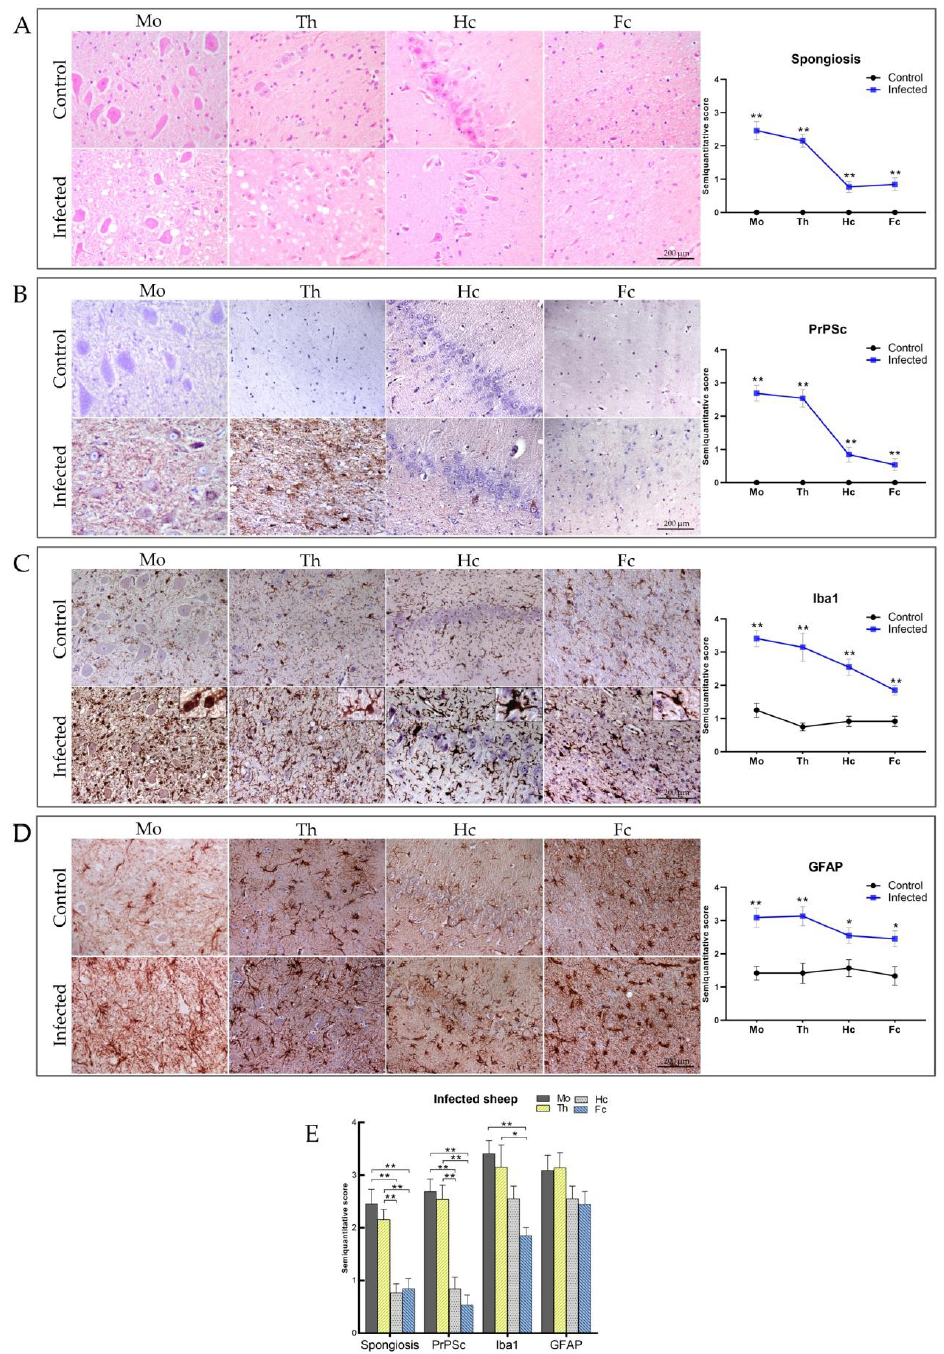
Figure 1. Representative neuropathology and immunohistochemical assessment of spongiosis, PrP Sc deposition, microgliosis, and astrogliosis in the CNS of control and scrapie-infected sheep in the medulla oblongata (Mo), thalamus (Th), hippocampus (Hc), and frontal cortex (Fc). Graphs depict semi-quantitative assessment values for each parameter analyzed. ( A ) Hematoxylin–eosin staining showing spongiosis changes in the CNS from scrapie-infected sheep, and an absence of spongiosis in control sheep. ( B ) Detection of PrP Sc with L42 antibody in scrapie-infected sheep brain regions. No immunolabelling was detected in the control group. ( C ) Ionized calcium-binding adaptor molecule-1 (Iba1) immunostaining showing increased microglial reactivity in scrapie-infected versus control